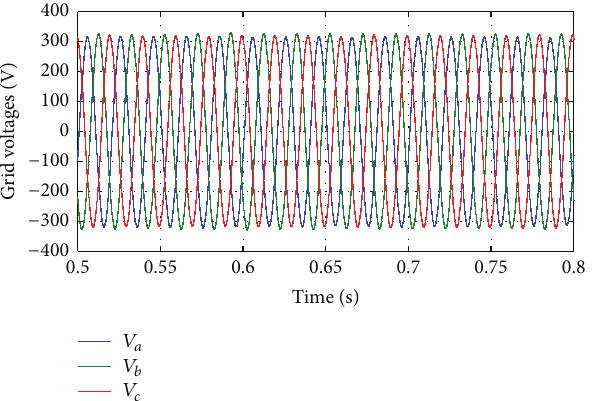
Figure 9: Three-phase grid voltages before fault.